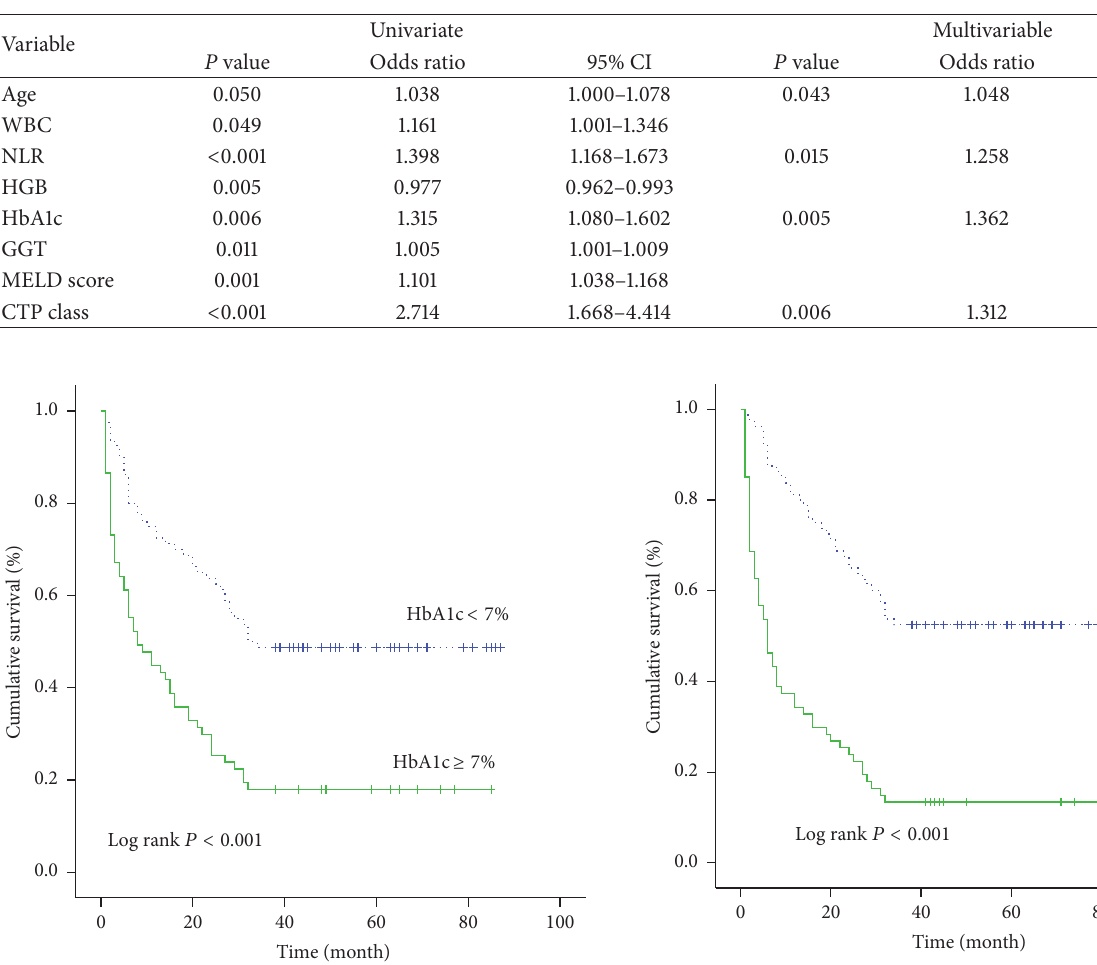
Table 2: Factors associated with death risk in patients with HCC and T2DM.